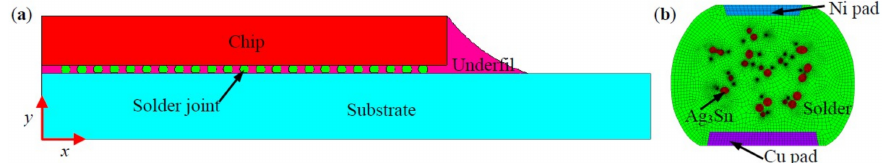
Figure 1. Geometry model and finite element (FE) model of flip ship assembly: ( a ) Geometry model of the assembly; ( b ) FE model of the corner